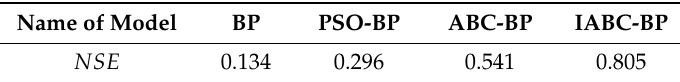
Table 5. NSE coefficient of each model.